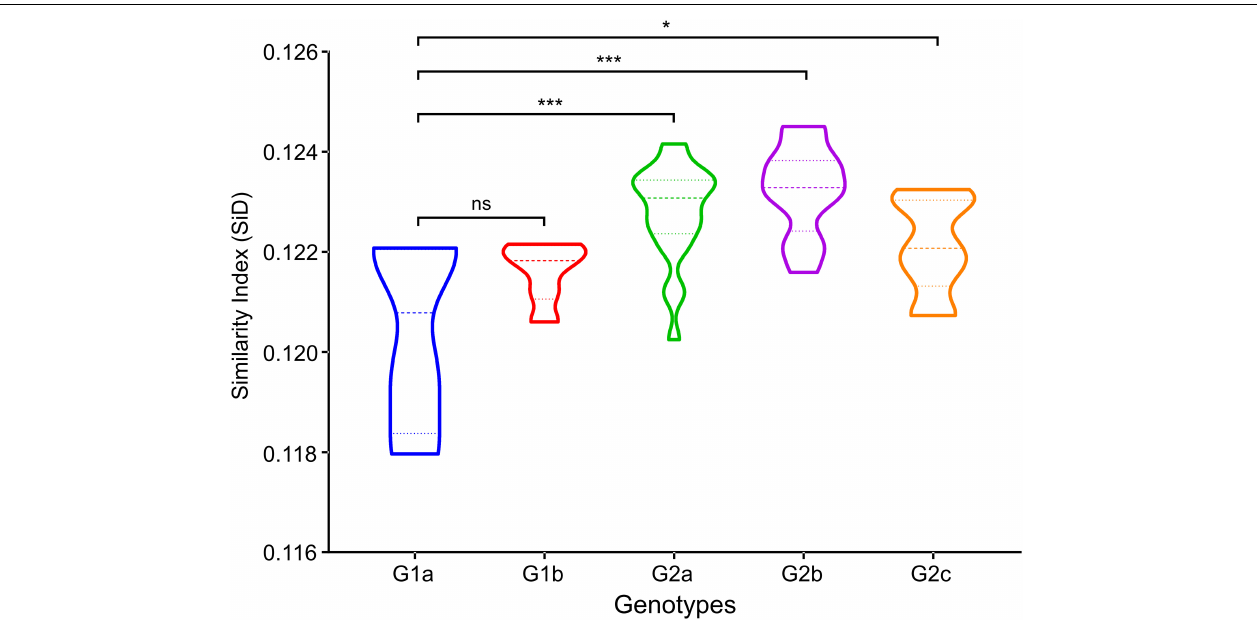
FIGURE 9 | Similarity index (SiD) analysis of complete genomic coding sequences of PEDV genome in relation to the host ( Sus scrofa ). In the plot, the abscissa represents the phylogroups, the ordinate represents the SiD value. One-way ANOVA and Dunnett’s test were employed to compare the mean of the D (A, B) values pertaining to Sus scrofa . Asterisk indicated the differential RCDI value of PEDV between G1 and G2 is statistically significant or very significant ( p < 0.001 or p < 0.0001), ns, not significant, p >